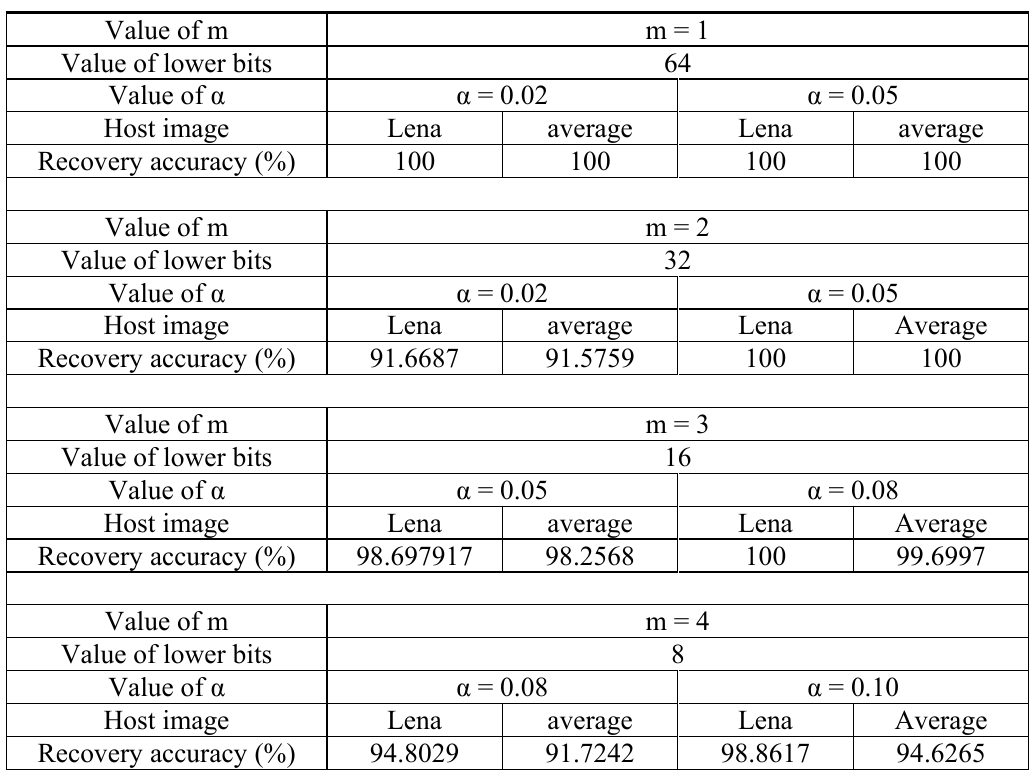
Table 2. Recovery accuracies of the secret text T with different values of m . The values of the lower bits are set to 2 7 – m .